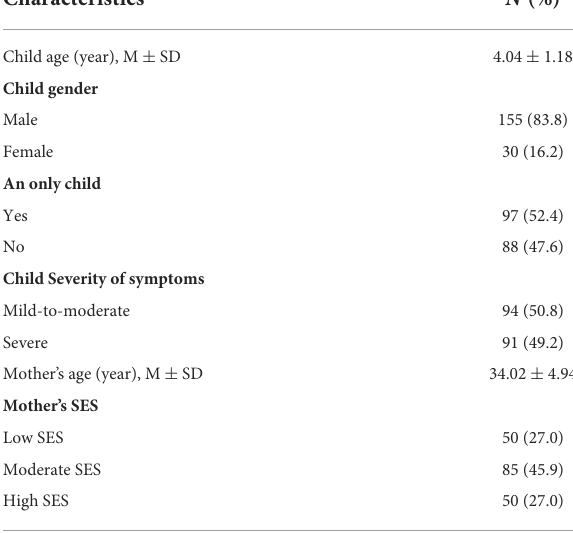
TABLE 1 Demographic characteristics of participants ( N = 185).